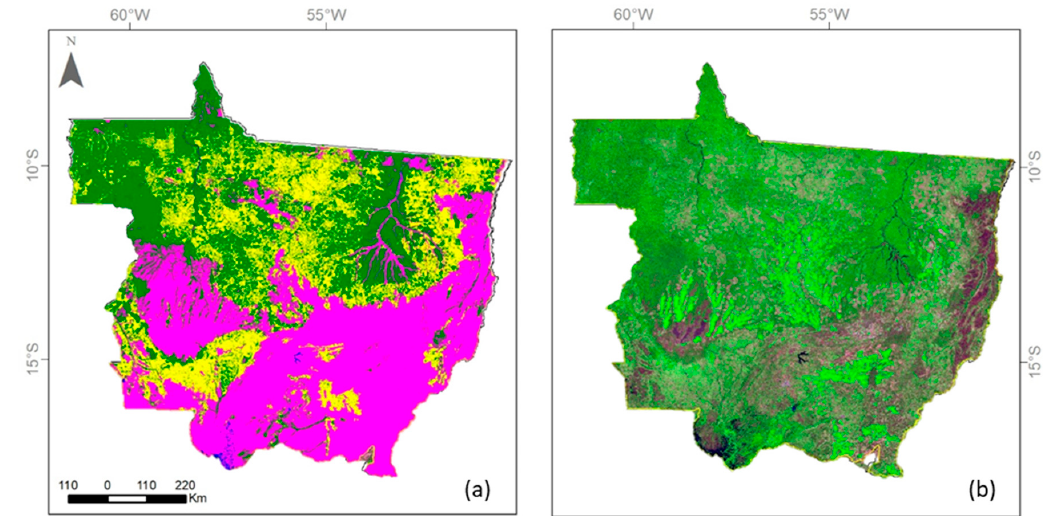
Figure 2. ( a ) PRODES 2015 showing the forest (in green) and non-forest (in magenta), deforestation (in yellow), and water (in blue) classes [47]; and ( b ) agriculture areas in 2015 (in light green) obtained from PROBA-V images [58].